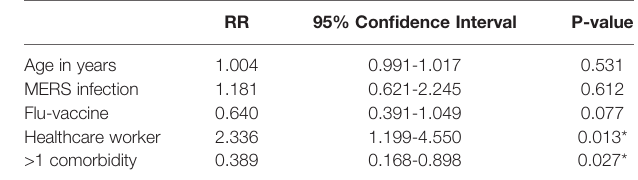
TABLE 4 | Multivariable logistic regression for independent predictors of SARS- CoV-2 infection in the study